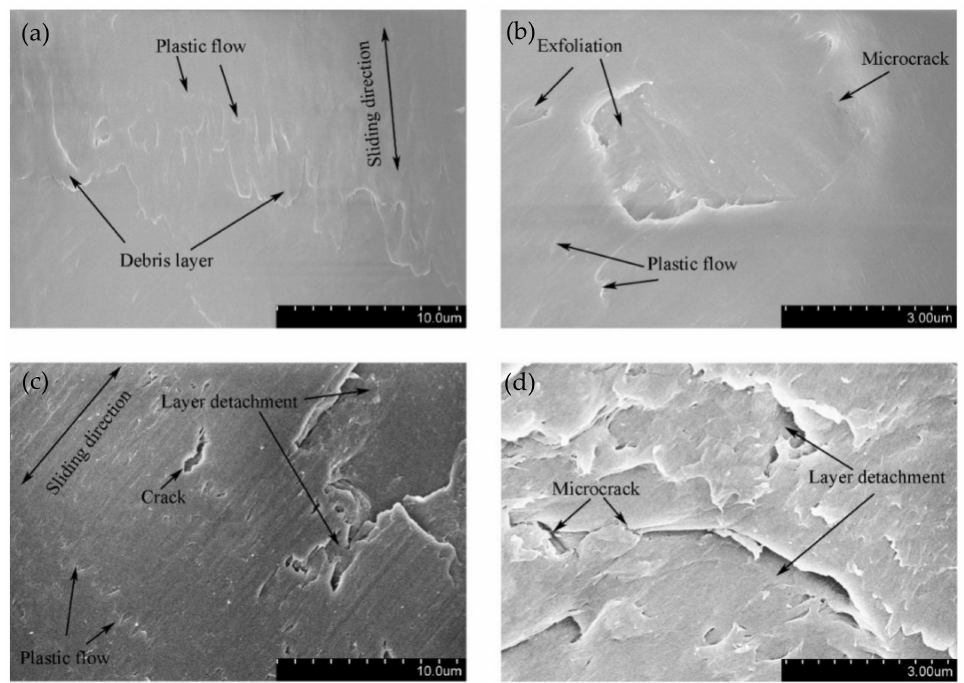
Figure 12. The scanning electron microscope (SEM) morphology of PVDF films in the contact region with F n = 15 N, ƒ = 15 Hz, and V c = 0 V: ( a , b ) D = ± 15 µ m and ( c , d ) D = ± 40 µ m.